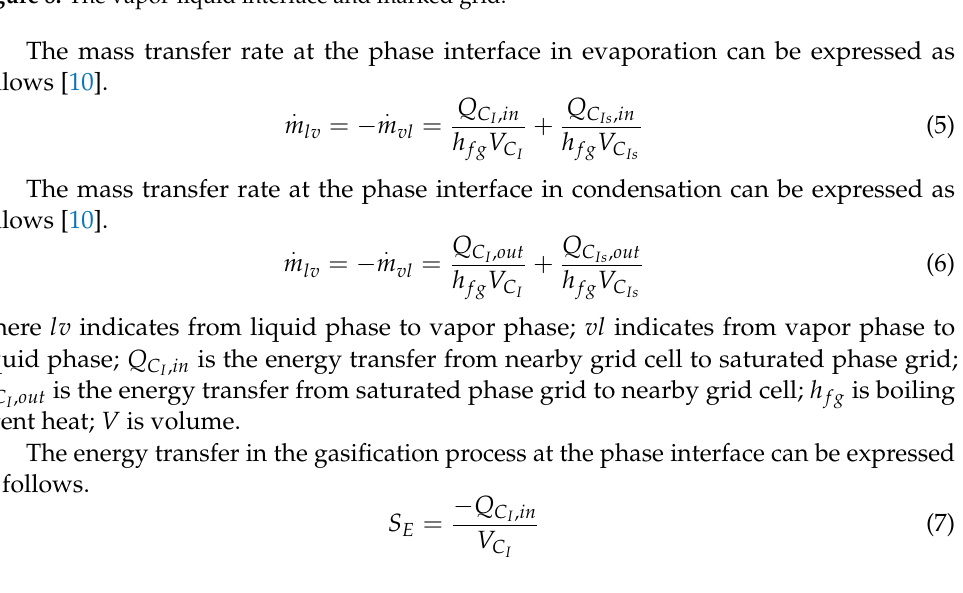
Figure 8. The vapor-liquid interface and marked